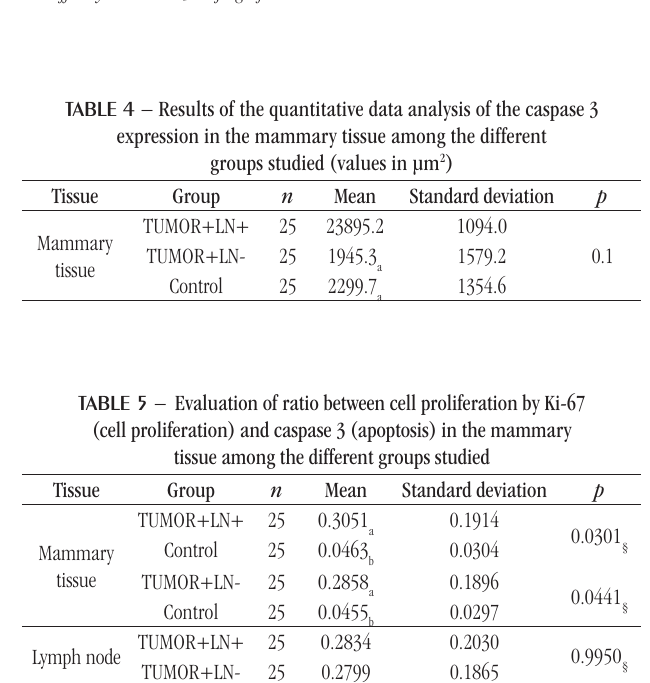
§: Kruskal-Wallis test – post-hoc Dunn test, in which the values followed by equal letters do not differ by more than 5% of significance.